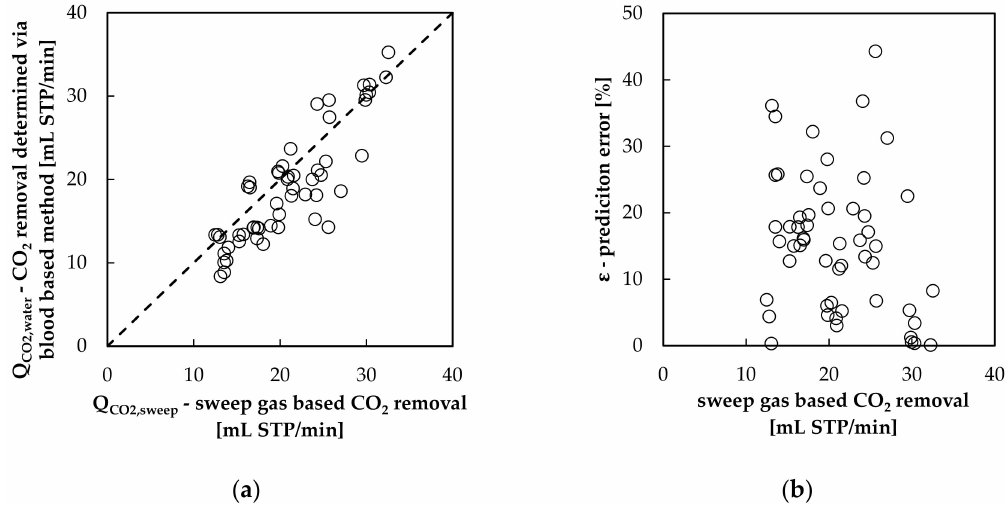
Figure 4. Performance of the Henry law applied for CO 2 dissolved in water: ( a ) comparison of blood-based to sweep flow-based CO 2 removal prediction methods and ( b ) prediction error ε in dependency from CO 2 removal rate.